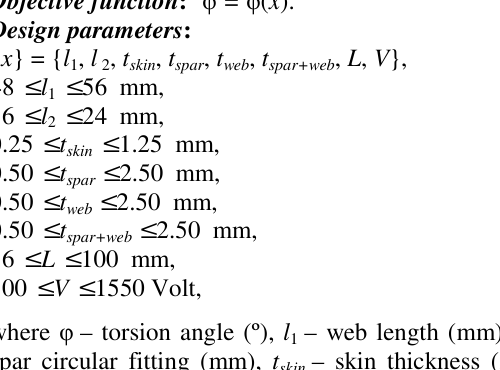
Fig 5. Design parameters of the helicopter rotor blade Objective function : φ = φ ( x ).